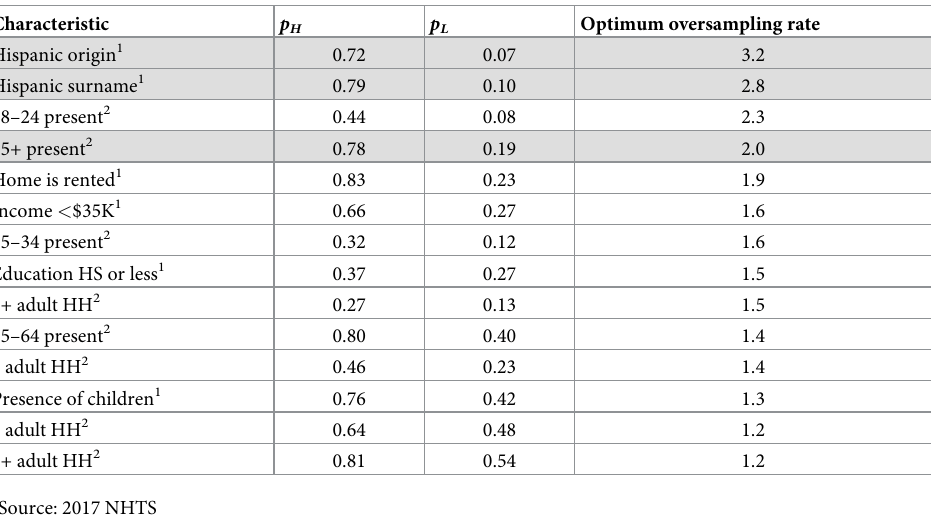
Table 4. Optimum oversampling